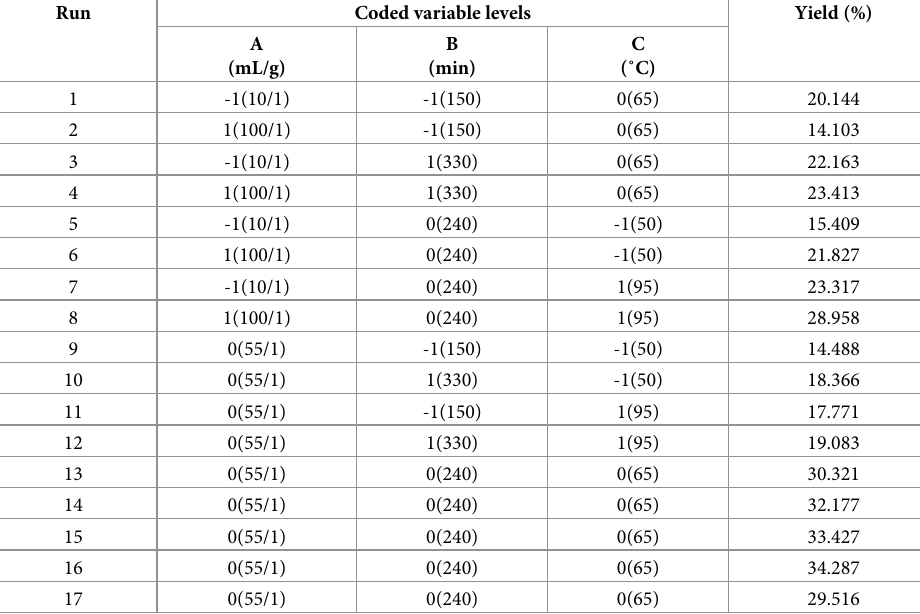
Table 1. Box–Behnken experimental design and results for the yield of total sugar.